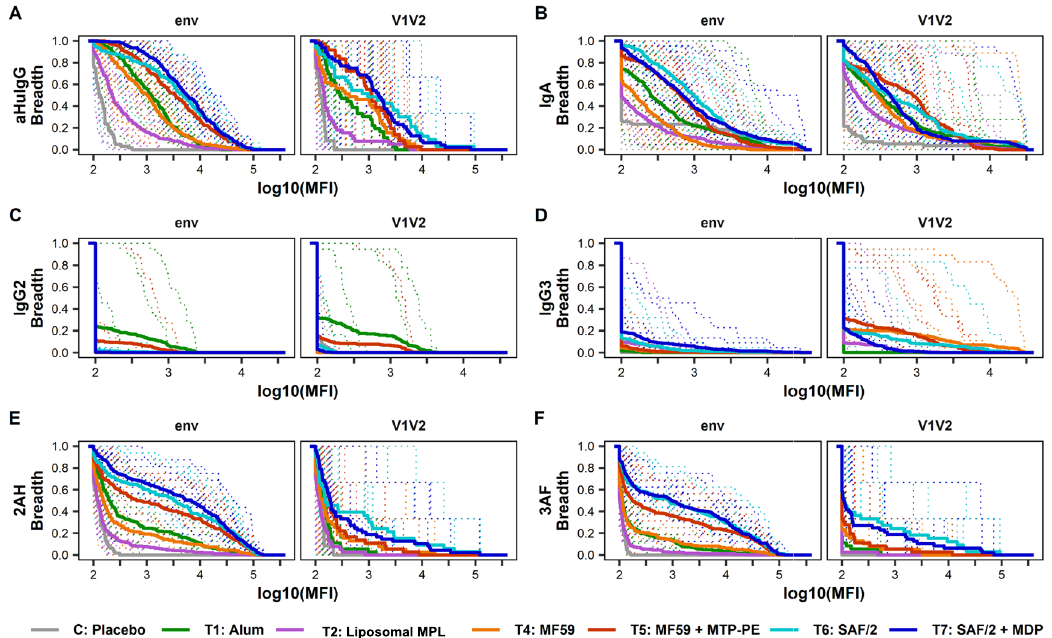
Fig. 4 Antibody-binding breadth. Magnitude-breadth of binding antibody responses within subclass ( A – D ), Fc γ receptor binding ( E , F ), and Fab recognition (envelope or V1V2 loop) measured by Fc Array ( A , E , and F ) and BAMA ( B , C , and D ) assays at 2 week post the second vaccine. 2AH indicates binding to Fc γ RIIAH, and 3AF indicates binding to Fc γ RIIIAF. Breadth at each point is de fi ned as the proportion of antigens within env and V1V2 antigen panels with log10(MFI) greater than or equal to each x -axis value. Antigen panels are listed in Supplemental Table 1, with the env panel including gp120 and gp140 antigens. Solid bold lines represent the median breadth for each arm, and the dotted lines are magnitude-breadth curves for each